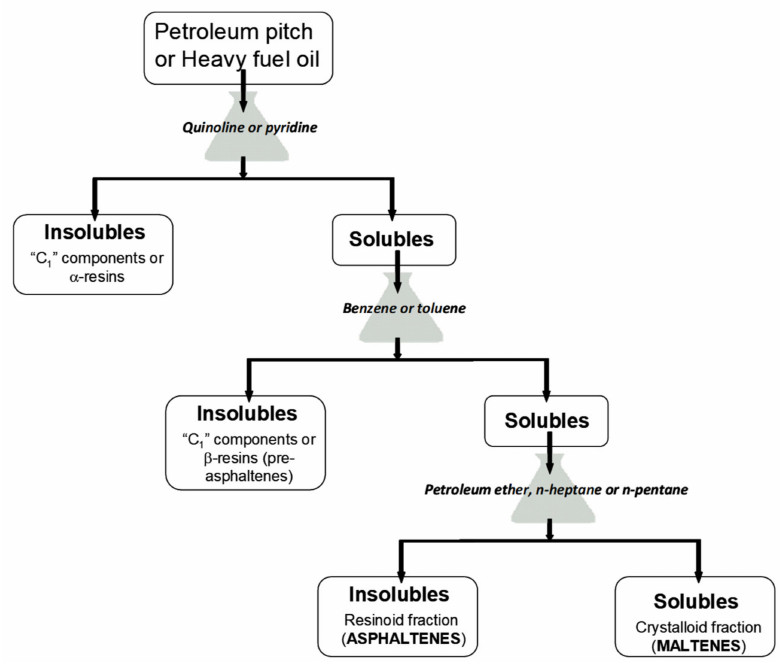
Figure 4. Extraction/solubilisation